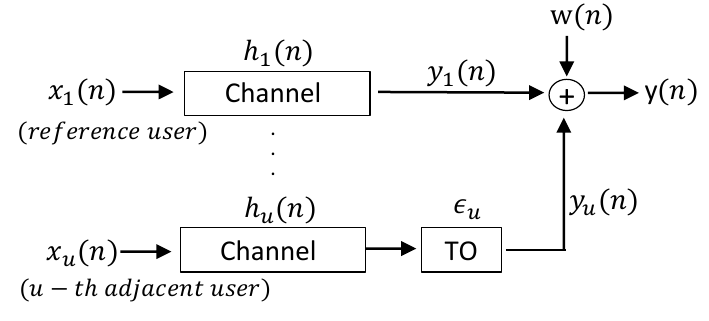
Figure 3. Baseband equivalent model of the uplink system by considering time offset between the